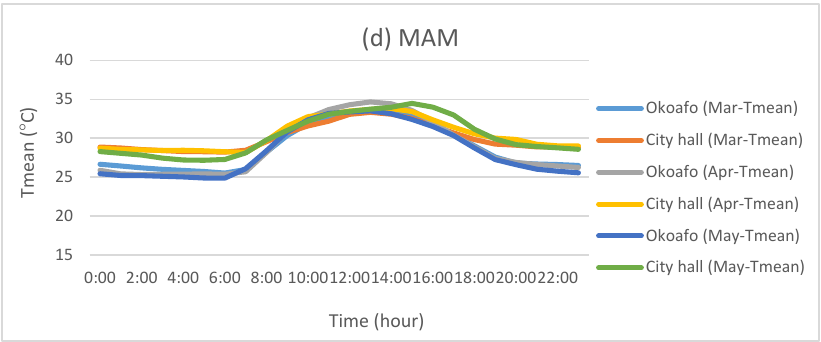
Figure 5. Diurnal pattern of Tmean at City hall and Okoafo in ( a ) JJA; ( b ) SON; ( c ) DJF and ( d ) MAM.